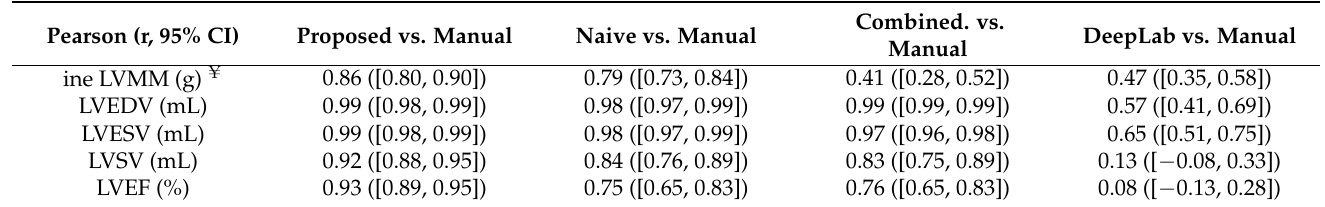
Table 3. Relationships (Pearson r and []=95% CI) for algorithm vs. manual LV function measurements for n = 180 images from 90 previously unseen ACDC test subjects. Pearson (r, 95% CI) Proposed vs. Manual Naive vs. Manual